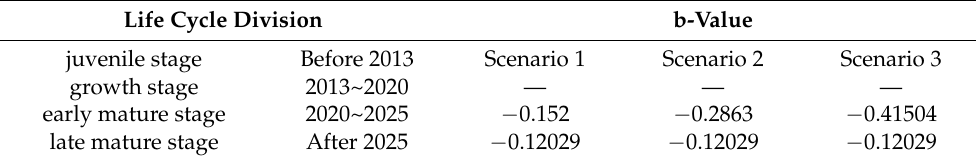
Table 3. b value under industry life